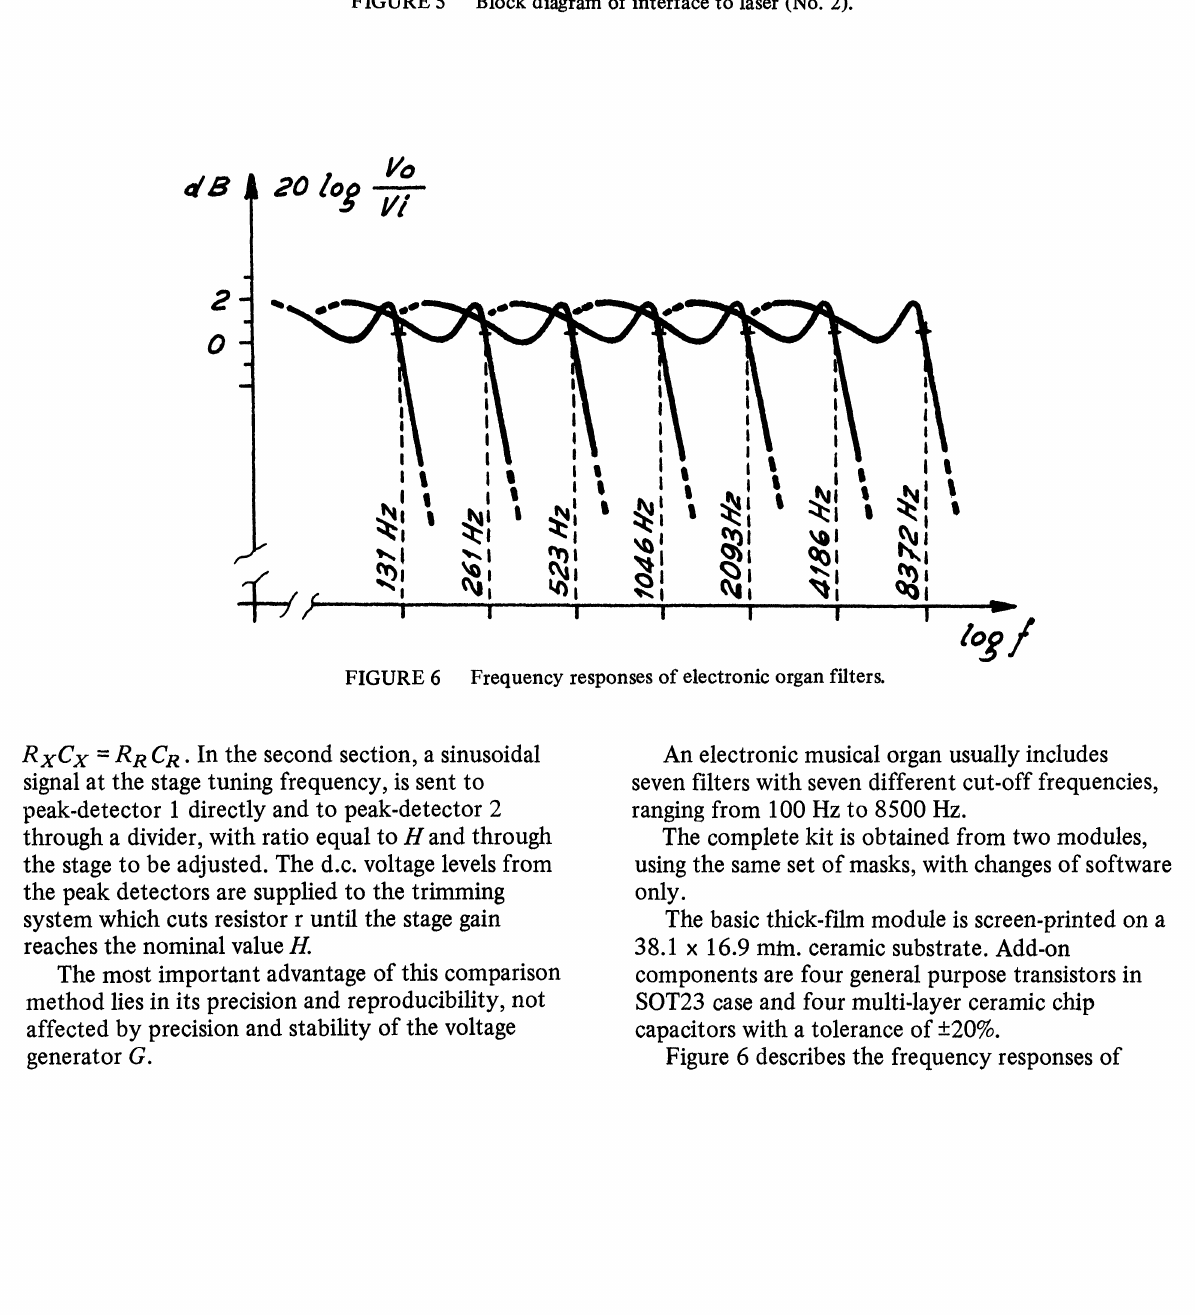
FIGURE 5 Block diagram of interface to laser (No. 2).